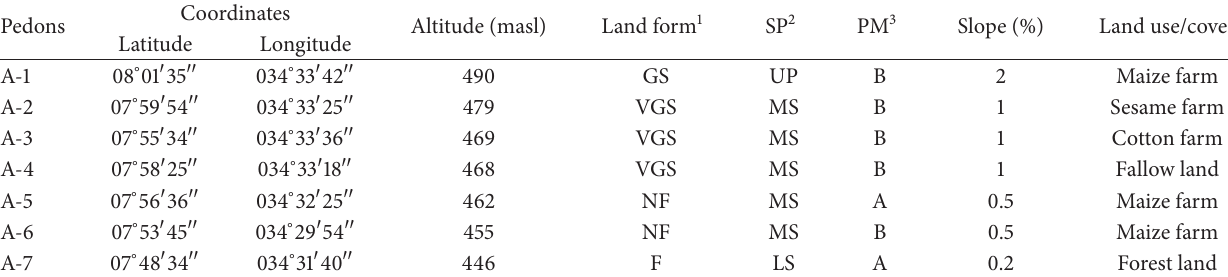
Table 1: Site characteristics and land use/cover of the study